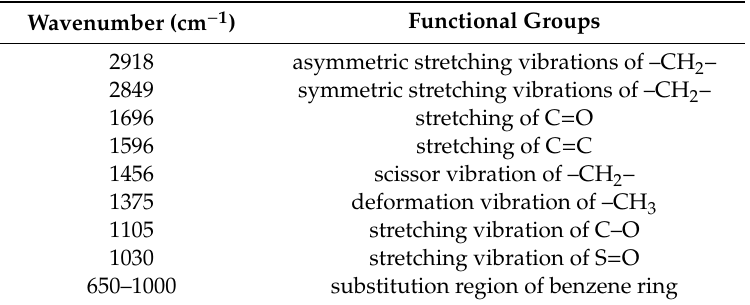
Table 6. Functional groups in asphalt rubbers [34–37].